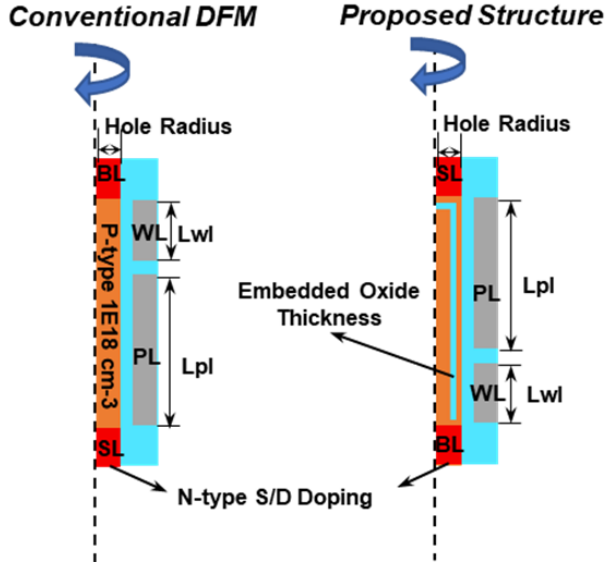
Figure 2. ( a – f ) The process flow of the1T DRAM with embedded oxide layer.